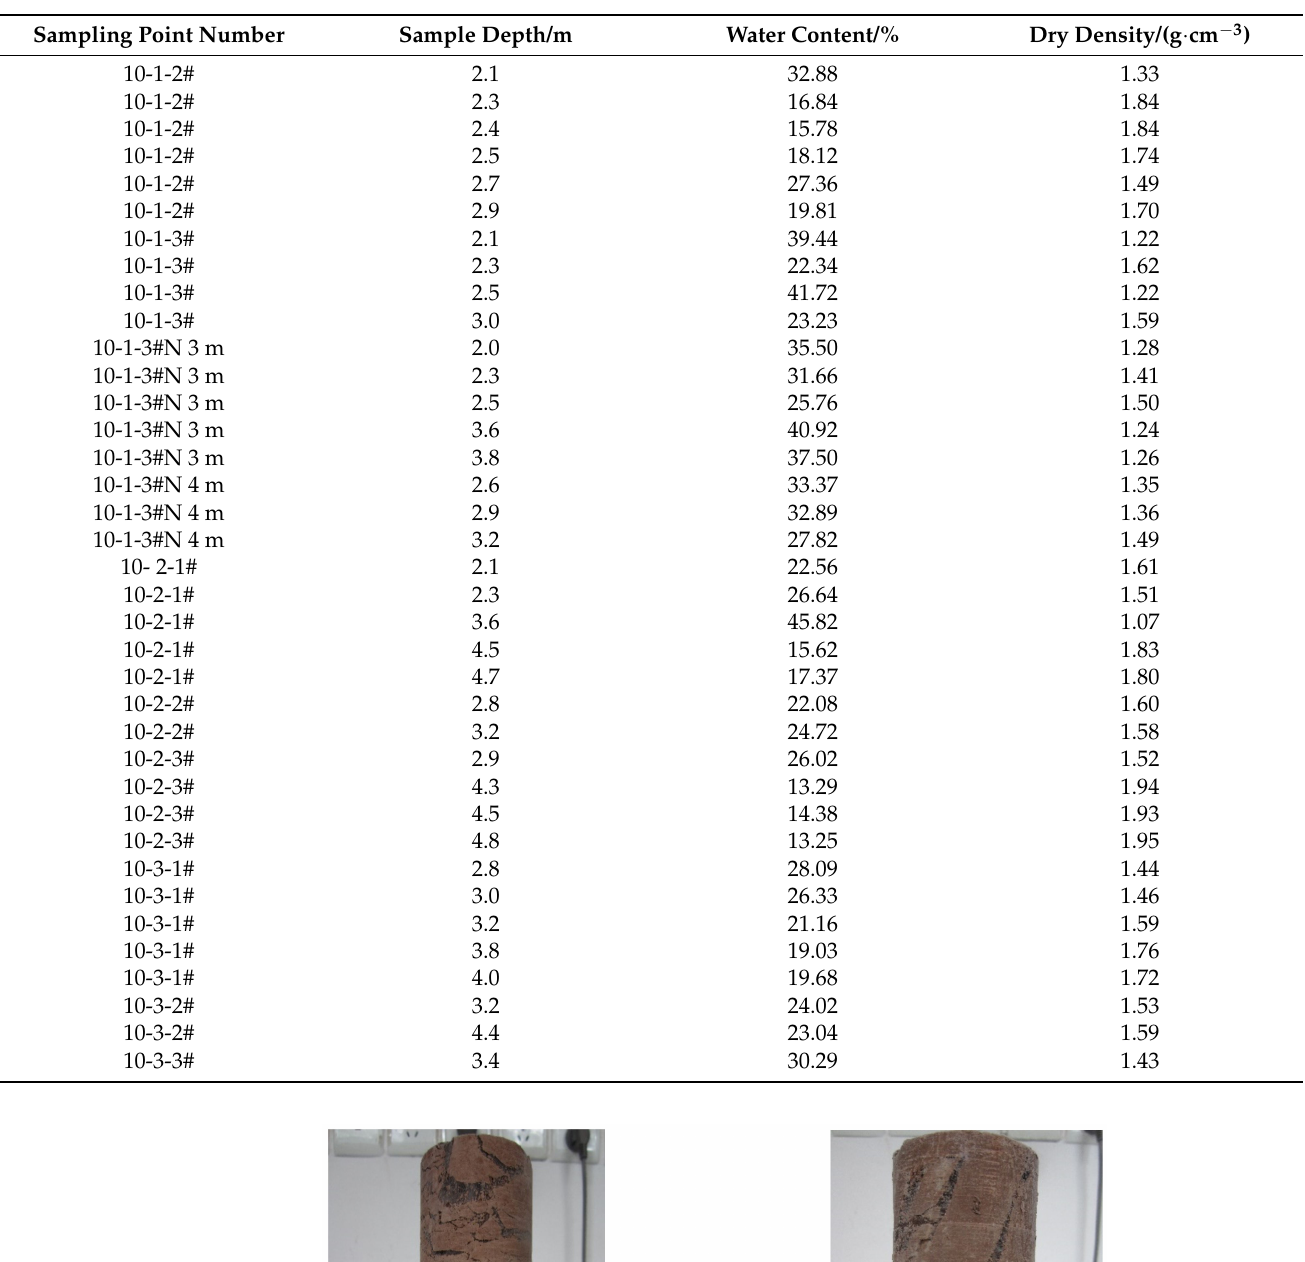
Table 1. Sampling point numbers, sample depths, water contents and dry densities of the standard test samples.